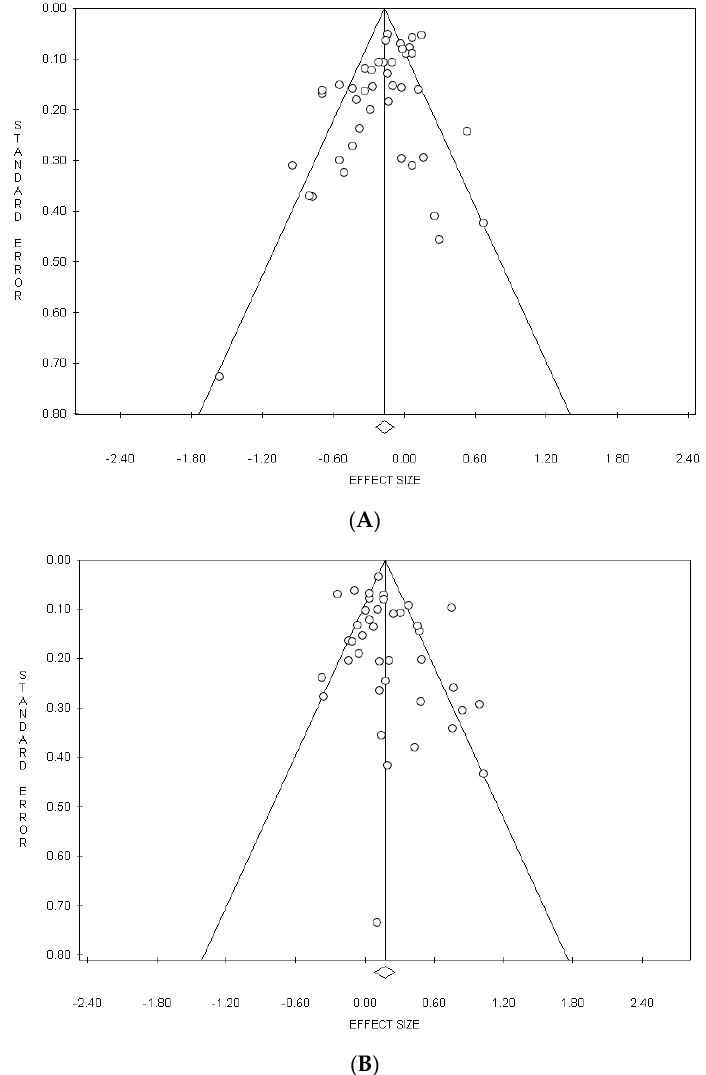
Figure 3. Funnel plots of the meta-analyses on the Healthy” ( A ) and “Meat/Western” ( B ) dietary Figure3. Funnelplotsofthemeta-analysesontheHealthy”( A )and“Meat / Western”( B patterns.